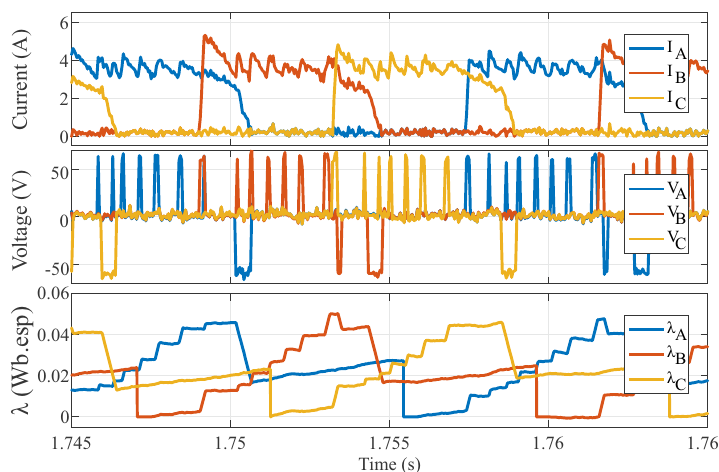
Figure 4. Simulation results of estimated flux linkage using a resettable integrator.